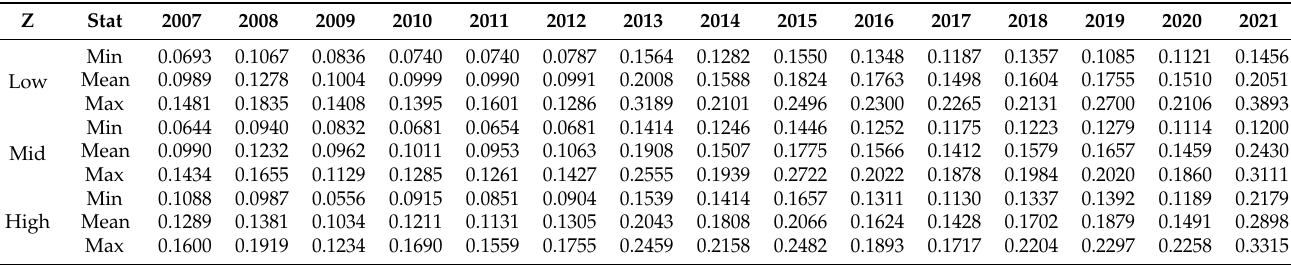
Table 4. Minimum, mean, and maximum NDVI values from 2007 to 2021.